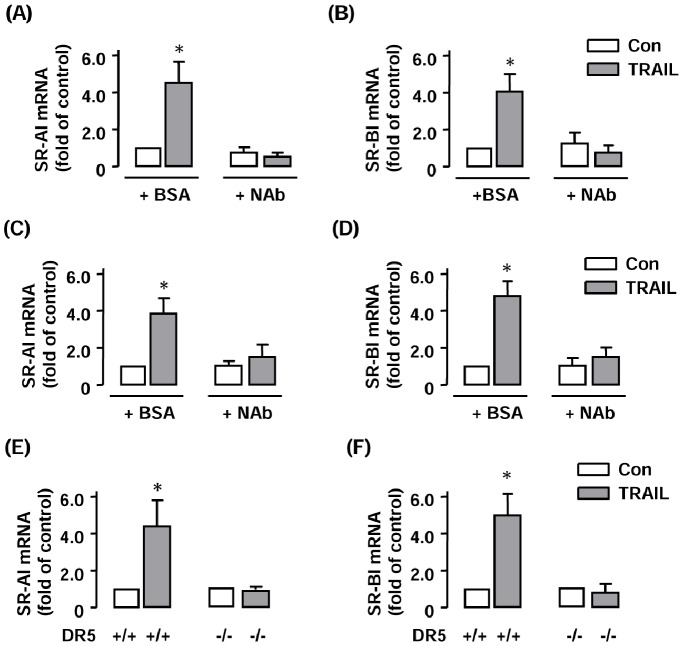
TRAIL-stimulated scavenger receptor expressions were blocked by TRAIL neutralizing antibody or DR5 deficiency.(A to D) Blockade of the effects of TRAIL on SR-AI and SR-BI expression with a TRAIL neutralizing antibody (NAb) (5 µg ml−1) in RAW264.7 (A & B) and THP-1 cells (C & D). Bovine serum albumin (BSA) in saline buffer was used as vehicle control. (E & F) The effects of TRAIL on SR-AI and SR-BI expression were abolished in DR5-deficient peritoneal macrophages. * P<0.05 vs control (Con), one-way ANOVA or unpaired t-test, n = 3–4.